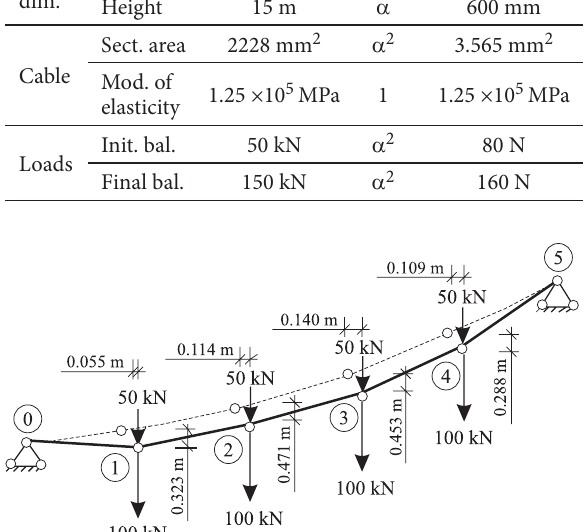
Table 2. Parameters of the structure and the model Parameter Cable Coeff. Model Over.